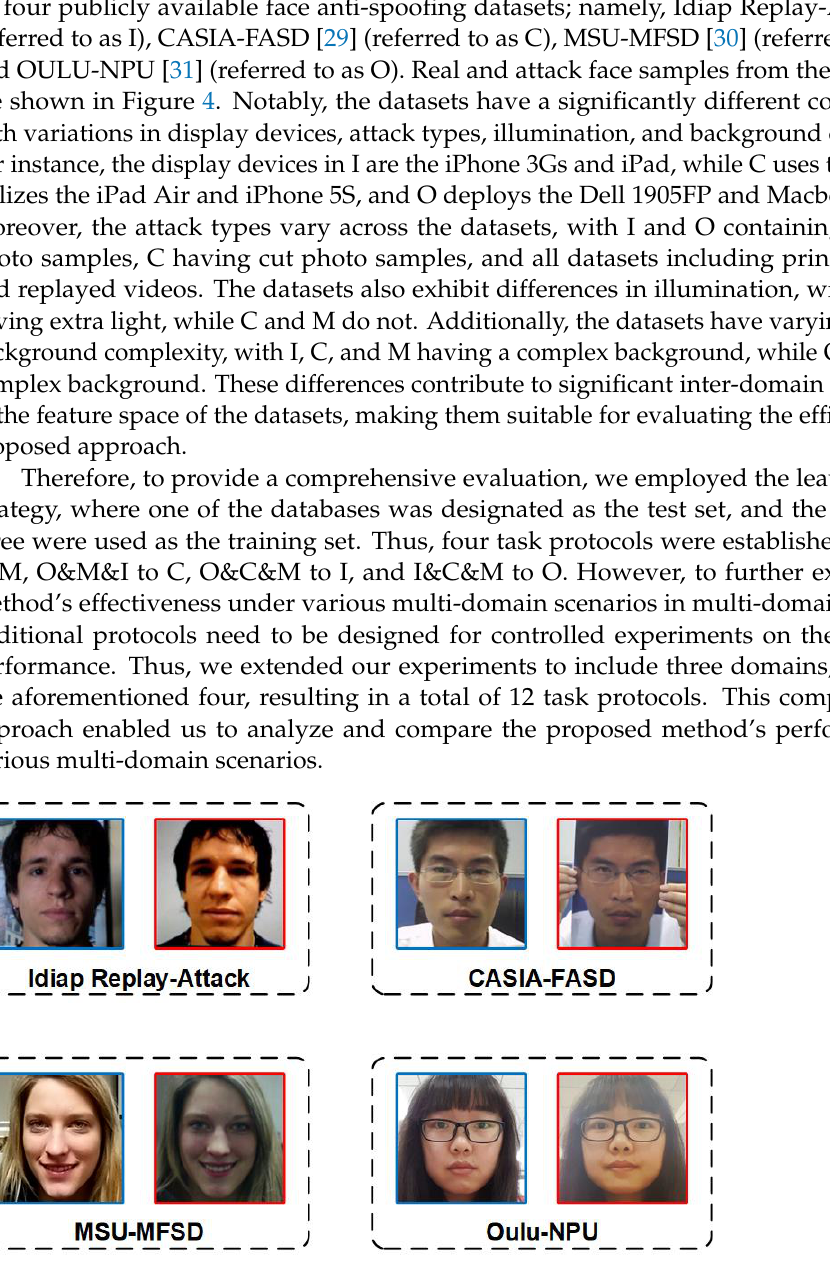
Figure 4. The figure showcases preprocessed sample frames from four publicly available face anti- spoofing databases; namely, Idiap Replay-Attack [28], CASIA-FASD [29], MSU-MFSD [30], and OULU-NPU [31]. Real face samples are demarcated by blue borders, while attack face samples are marked by red borders. The observed variations among the domains are attributed to distinct sampling environmental conditions, emphasizing the need for the design of multiple task protocols to evaluate generalization